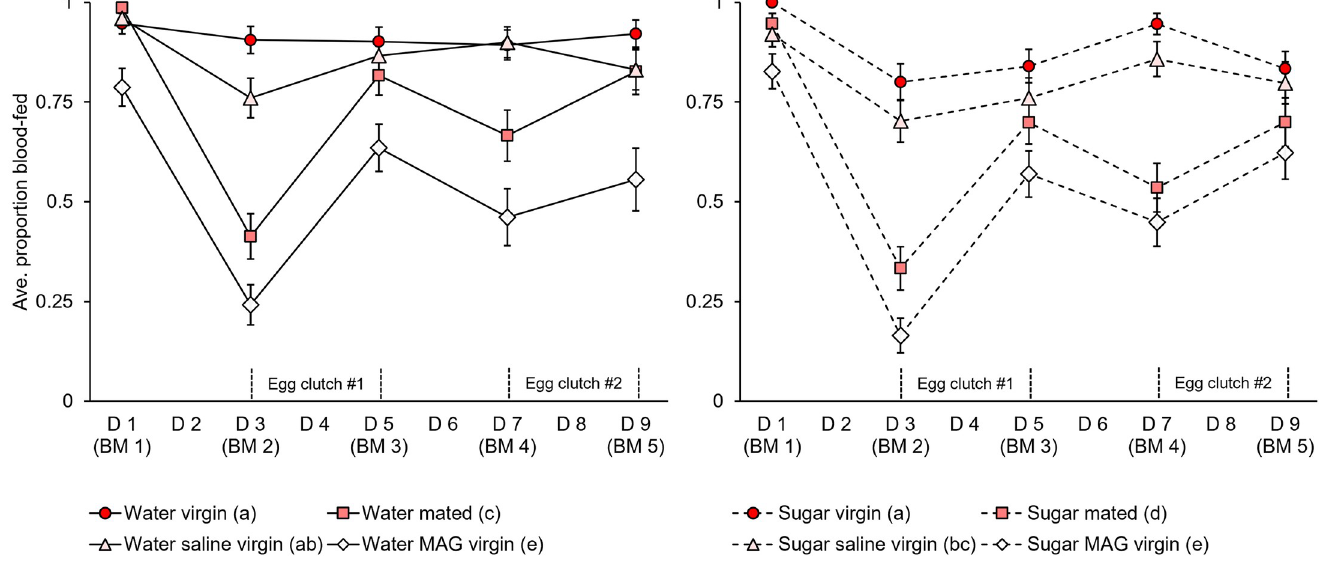
Fig 5. Mating, MAG, and sugar feeding lower blood-feeding avidity over multiple successive meals. Blood-feeding avidity for mated and MAG-treated females was lower compared to non-injected and saline-injected virgins, particularly in blood meals two and four (n = 75 total females per group). Egg laying activity occurred primarily between blood meals two and three (first clutch) and four and five (second clutch). Sugar feeding led to lower blood-feeding avidity over multiple blood meals compared to groups that fed on water alone. Error bars denote SE of sample proportions. For detailed egg laying data collected from trial three of these experiments, see S5 Fig. Letters in parentheses next to the treatment group names denote H-B-corrected post-hoc comparison p-values.